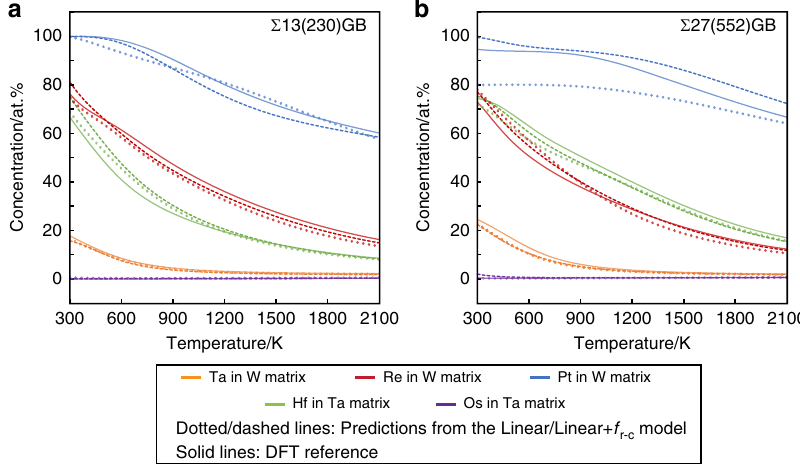
Fig. 6 GB solute concentration isotherms calculated based on the WC model (Eq. (5)). a Σ 13 (230)-GB; b Σ 27 (552)-GB. The solid lines represent the isotherms calculated using DFT-computed interaction energies, while the dotted (dashed) lines represent the isotherms calculated using the interaction energies predicted from the linear (linear + f r-c ) model based on Eq. (1) (Eq.